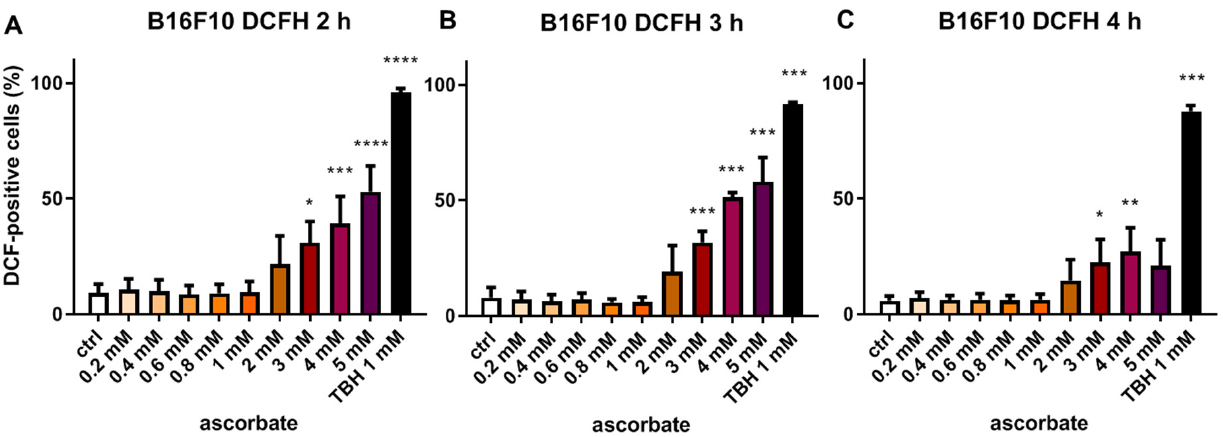
Figure 3. Effects of ascorbate on ROS production in melanoma cells. B16F10 cells (30,000 cells/well), were treated with ascorbate (0–5 mM), and measured flow-cytometrically 2 h ( A ), 3 h ( B ), and 4 h ( C ) after treatment. Shown are the mean values ± SD of DCF-positive cells of three independent experiments, indicating cells with elevated intracellular ROS levels. *: p ≤ 0.05; **: p ≤ 0.01; ***: p ≤ 0.001; ****: p ≤ 0.0001. DCF, 2 (cid:48) ,7 (cid:48) -dichlorofluorescein (oxidized form); DCFH, 2 (cid:48) ,7 (cid:48) -dichlorofluorescein (reduced form); ROS, reactive oxygen species; TBH, tert-butyl hydroperoxide; SD, standard